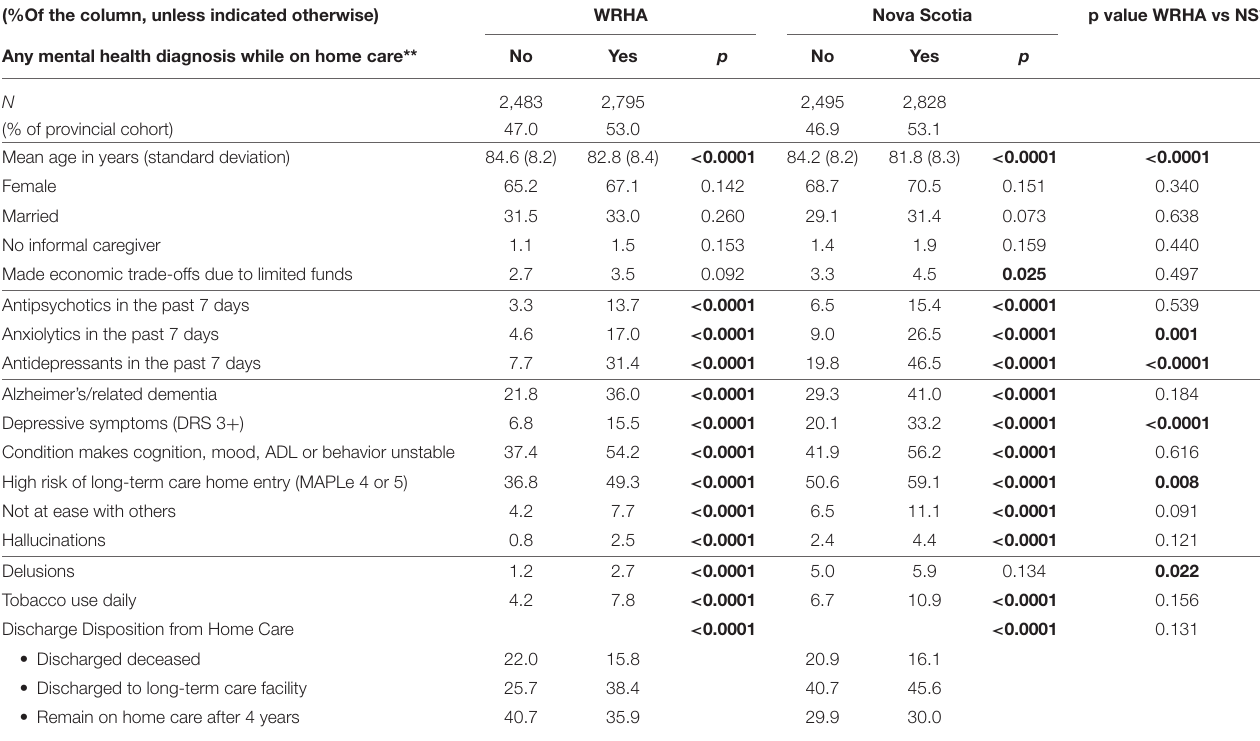
TABLE 3 | Sample characteristics at latest RAI-HC assessment, those with and without mental health diagnosis. (%Of the column, unless indicated otherwise) WRHA Nova Scotia p value WRHA vs